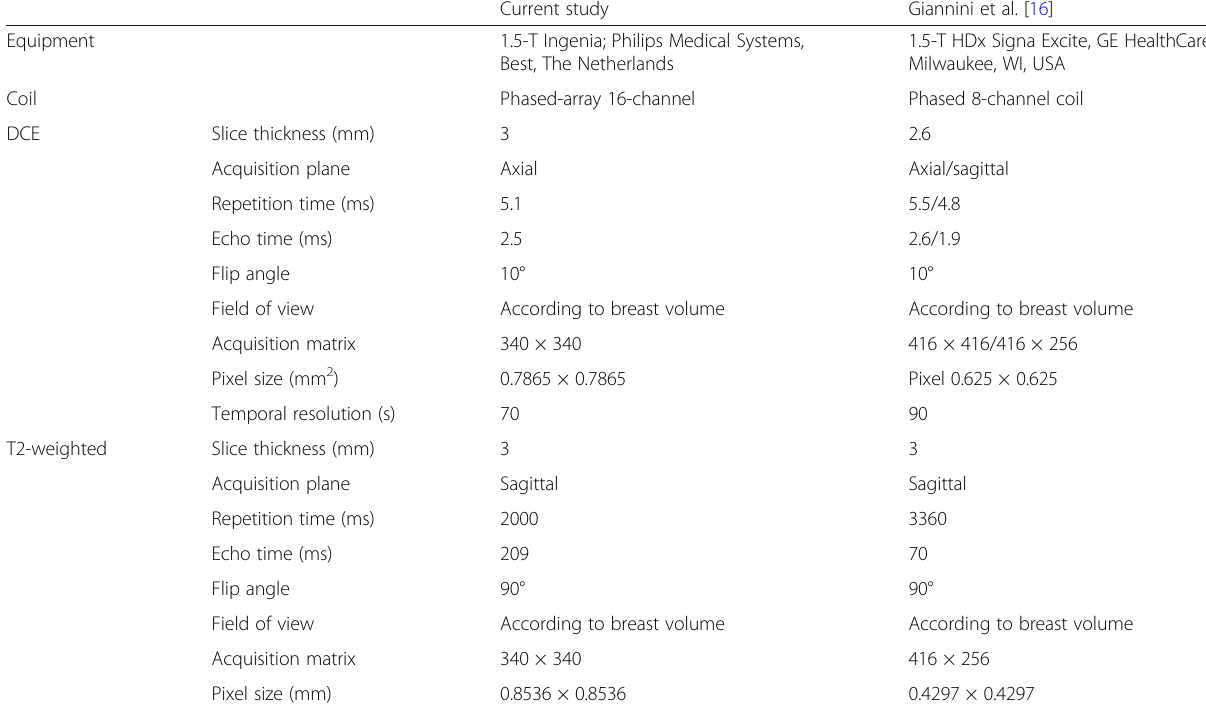
Table 1 Differences between scanner, devices, and technical parameters of dynamic contrast-enhanced acquisition used in the current study and those used in the work by Giannini et al.